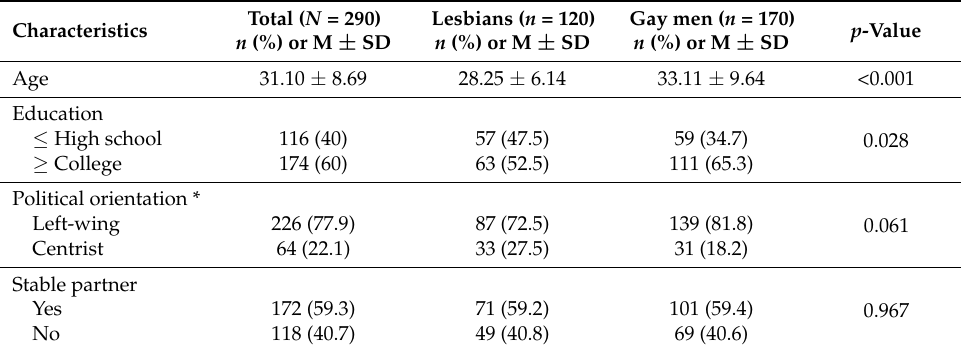
Table 1. Sociodemographic characteristics of participants ( N =